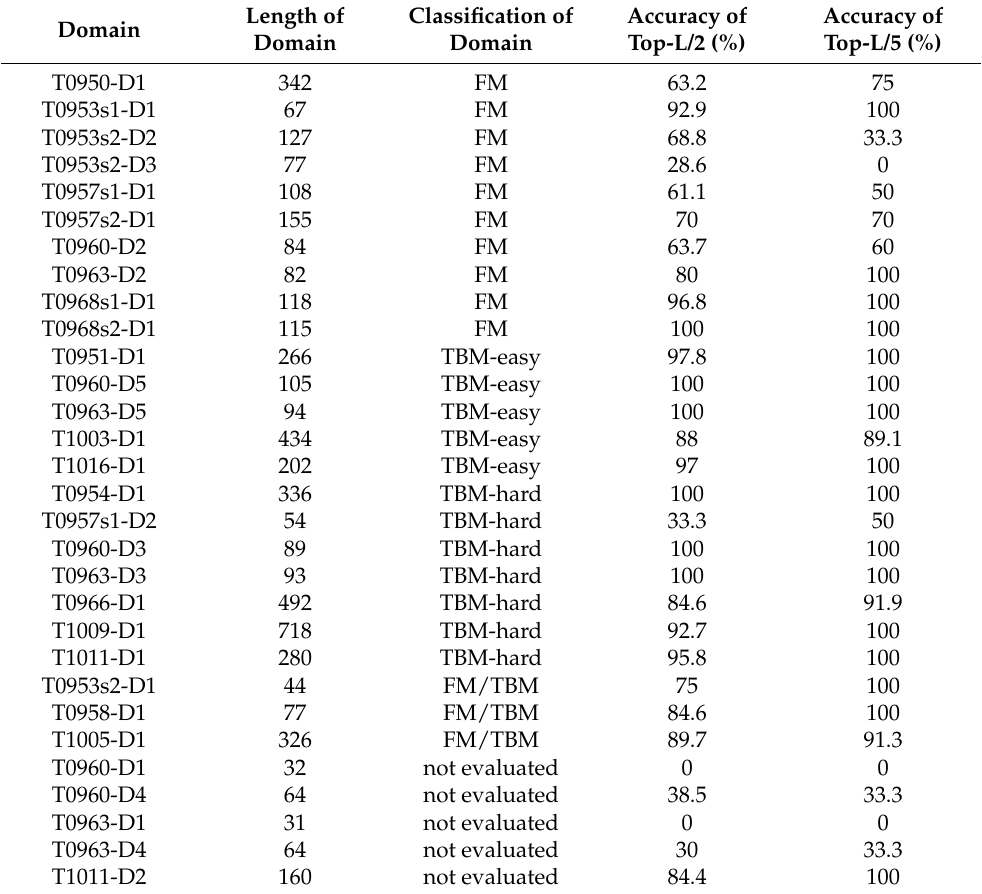
Table 4. Performance of COMTOP scheme in CASP13. Top-L/2 and top-L/5 overall accuracy is shown for 30 FM/TBM and FM domains. Targets are ordered by domain